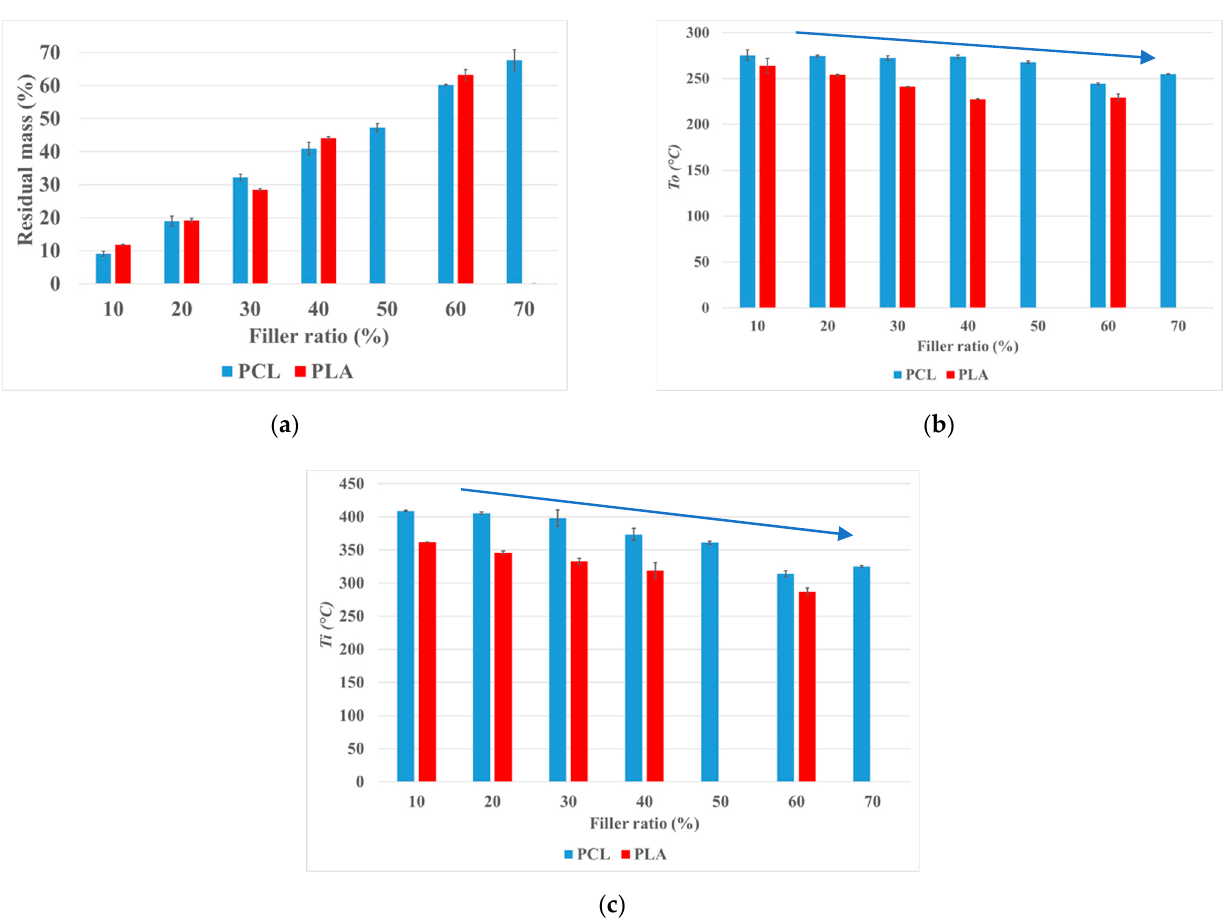
Figure 6. ( a ) Evaluation of mass residual in biocomposites. ( b ) Influence of ratio filler dose on the onset thermal degradation temperature To . ( c ) Influence of ratio filler on the temperature of the inflection point of the degradation curve Ti .